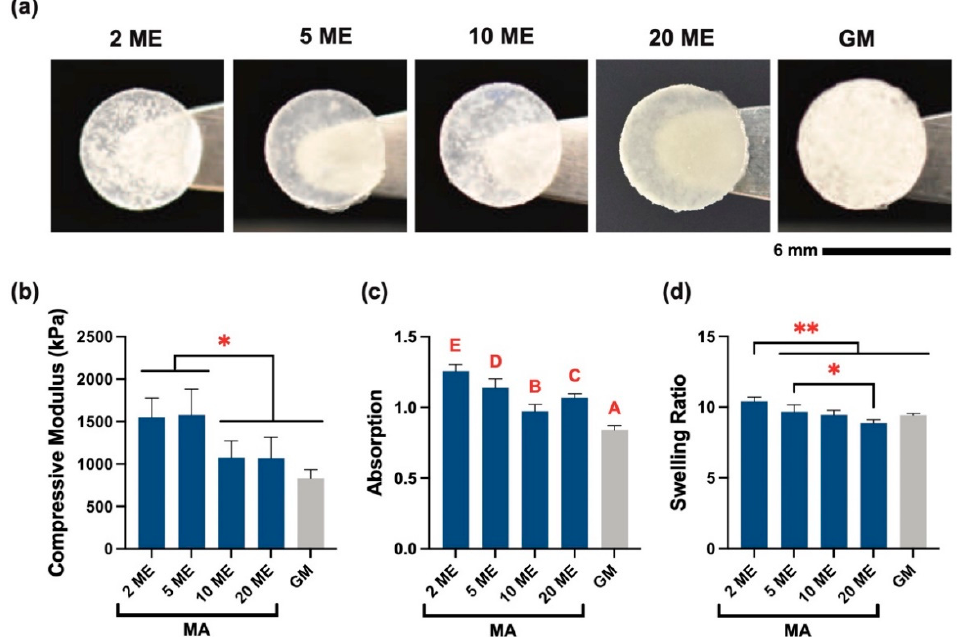
Figure 4. MeSDVC hydrogels had a stiffness close to native cartilage and minimal swelling/contraction. ( a ) The punched-out hydrogels of UV crosslinked MeSDVC hydrogels are shown. There was slight opacity but minimal color differences across groups. ( b ) Interestingly, the lowest functionalized MA MeSDVC (2 and 5 ME) had the highest compressive moduli (1550 ± 230 kPa and 1580 ± 310 kPa, respectively) (n = 4–6), which is close to that of native articular cartilage (~1800 kPa). ( c ) The absorption of the MeSDVC hydrogels was close to 1.0 (ranging between 0.84 ± 0.03 and 1.26 ± 0.05) (n = 3–6) and had minimal diameter changes. Absorption ratios close to 1 indicated minimal water absorption after fabrication, which has advantages in material retention in the defect as the hydrogels may not contract or swell out. ( d ) The swelling ratios were in the range of 8.87 ± 0.24 to 10.41 ± 0.30 (n = 3–6). Scale bar: 6 mm. * p < 0.05. ** p < 0.01. Different letters indicate significance from each other ( p < 0.05).